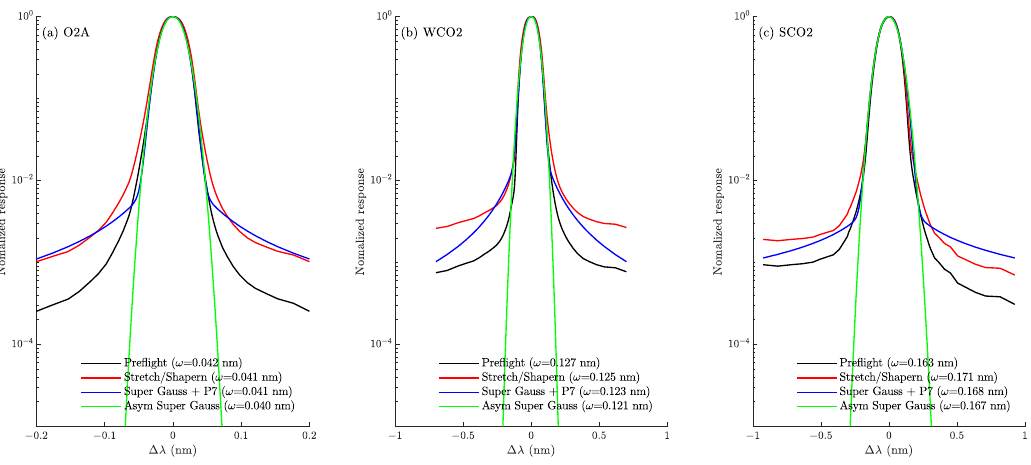
Figure 3. ( a ) Preflight ILS, retrieved ILS using stretch/sharpen, super Gaussian+P7, and asymmetric super Gaussian function at 758 nm for footprint 1; ( b ) the same as for ( a ) but at 1596 nm and ( c ) at 2066 nm. FWHM ( ω ) for each type of ILS function is